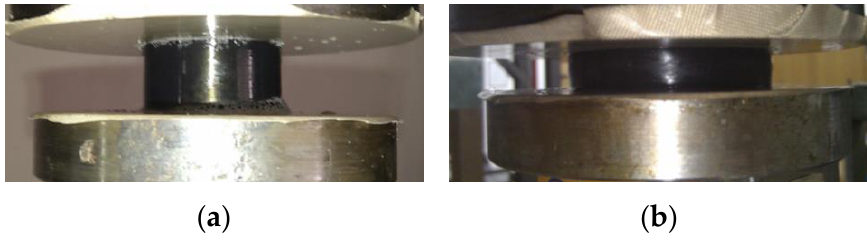
Figure 2. Rubber sample in: ( a ) unloaded and ( b ) compressed state.